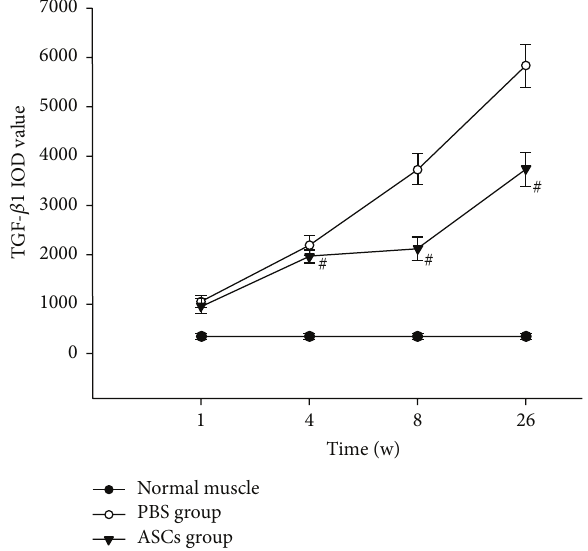
Figure 7: TFG- 𝛽 1 IOD value of each IHC staining image at different time points after irradiation ( # 𝑃 < 0.05 versus PBS group).